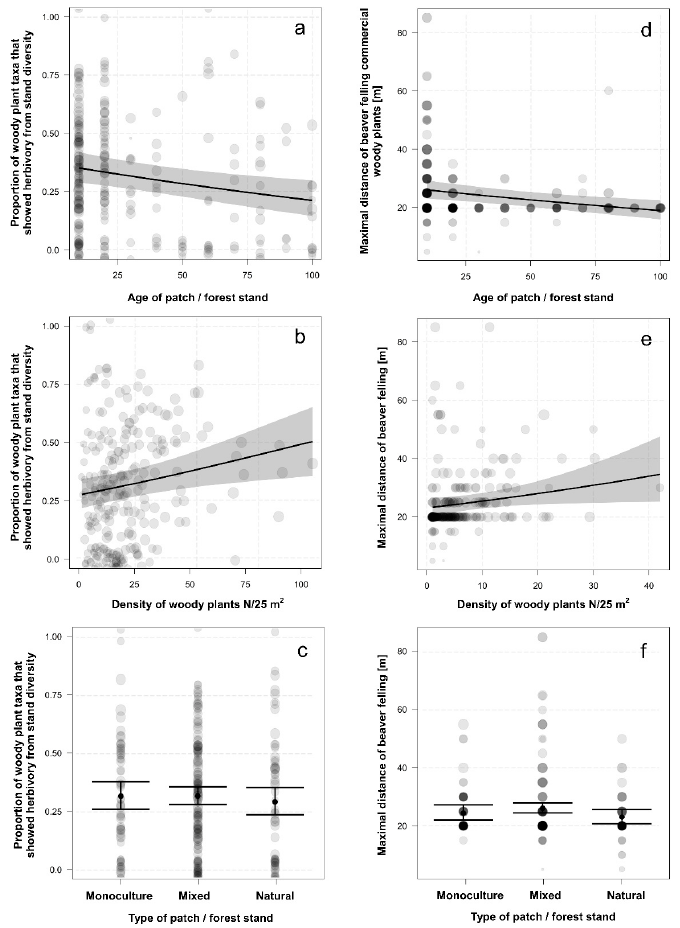
Figure 6. The proportion of woody plant taxa that showed herbivory from patch diversity and the maximal distance of beaver felling in relation to: ( a , d ) age of the patch (estimate ± 95% CI), ( b ) the density of woody plants (estimate ± 95% CI), ( e ) the density of commercial woody plants (estimate ± 95% CI), and ( c , f ) type of the forest patch (mean ± SE). The size of the circles reflects the number of woody plants in the patch.